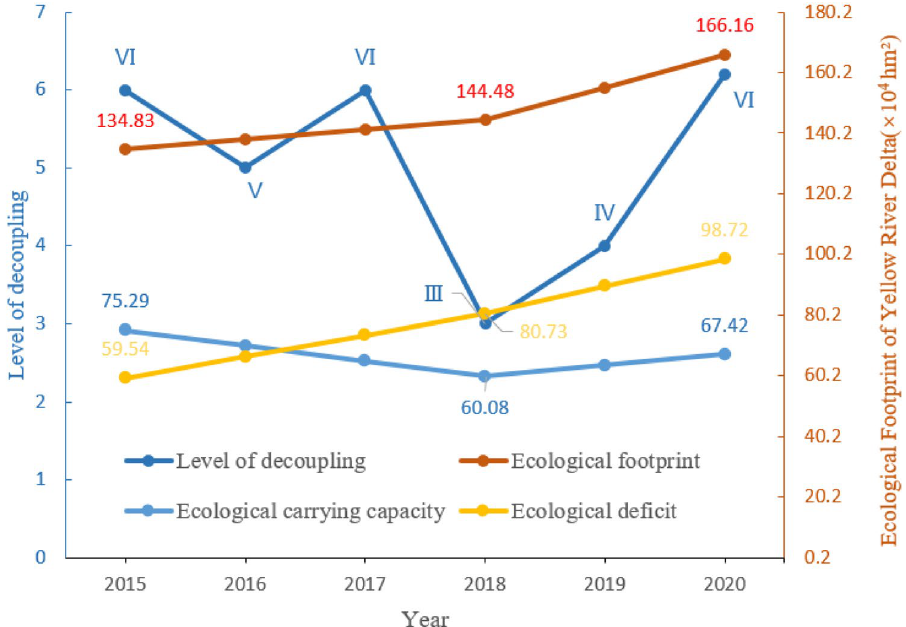
Figure 10. Ecological footprint and decoupling time series